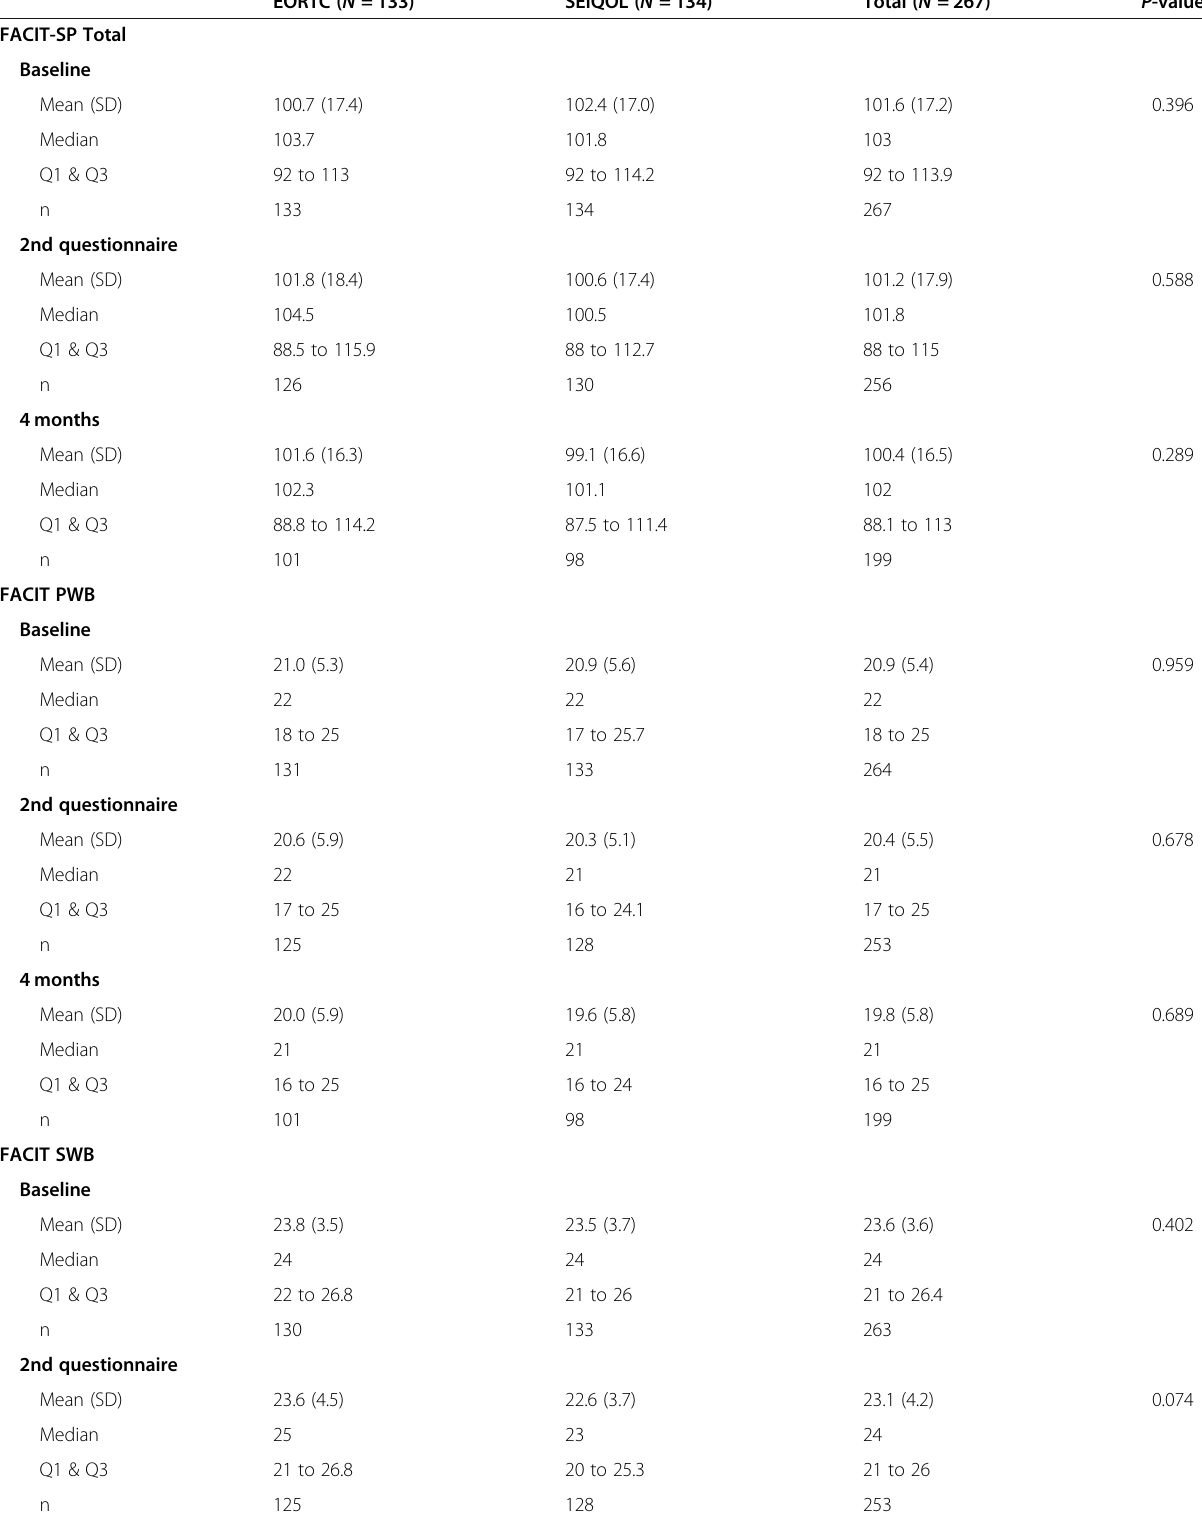
Table 2 Outcomes a over time for analyzed